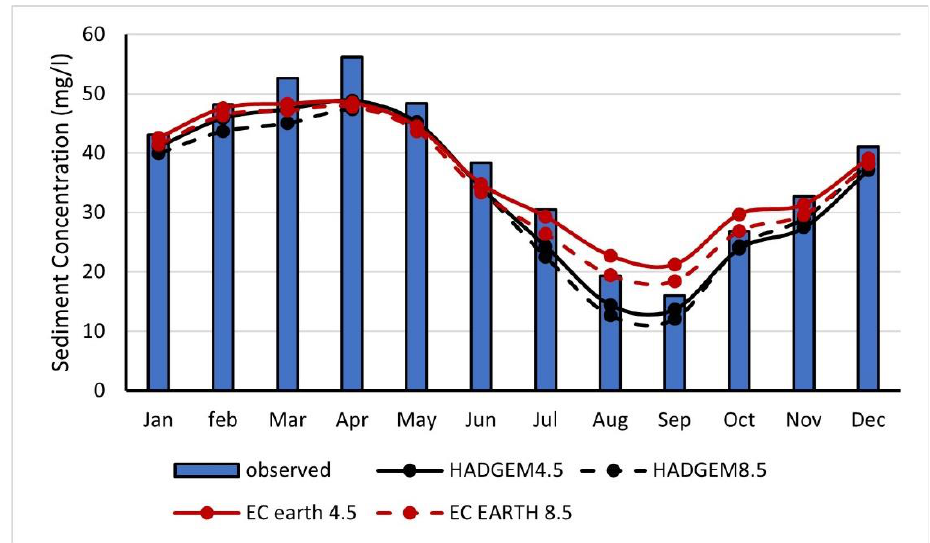
Figure 7. Average monthly sediment concentration for climate scenarios, RCP 4.5 and RCP 8.5 of the GCM climate models, HadGEM2 and EC-Earth .